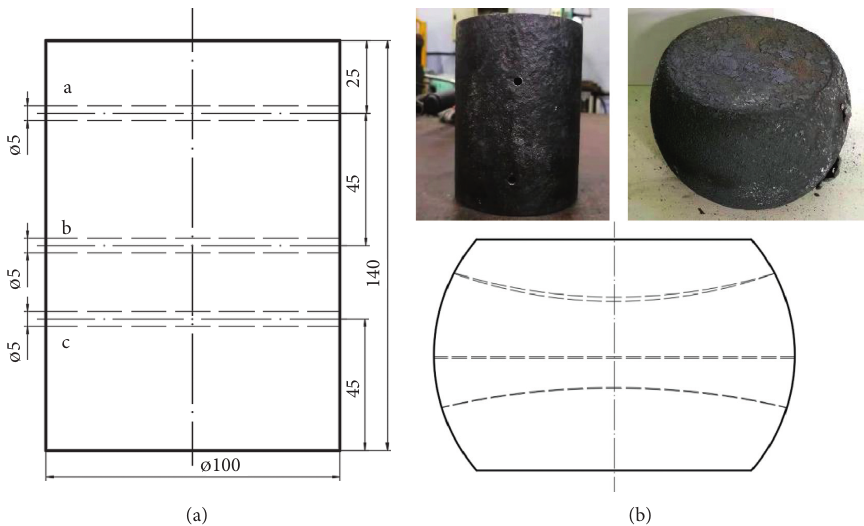
Figure 5: (a) Schematic diagram of through-hole location. (b) Deformation and shape of the cylindrical through-hole when the deformation is 36.5%.